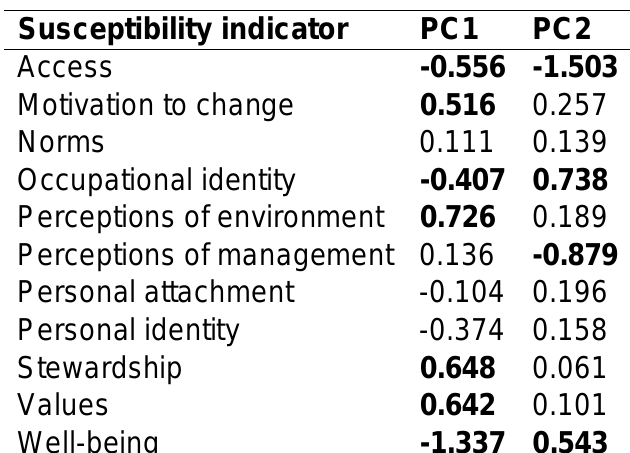
Table S1. Factor loadings for each susceptibility indicator on PCA axes. Factor loadings greater than 0.4 (bold) on any given principal component are generally considered to contribute substantially to that component.